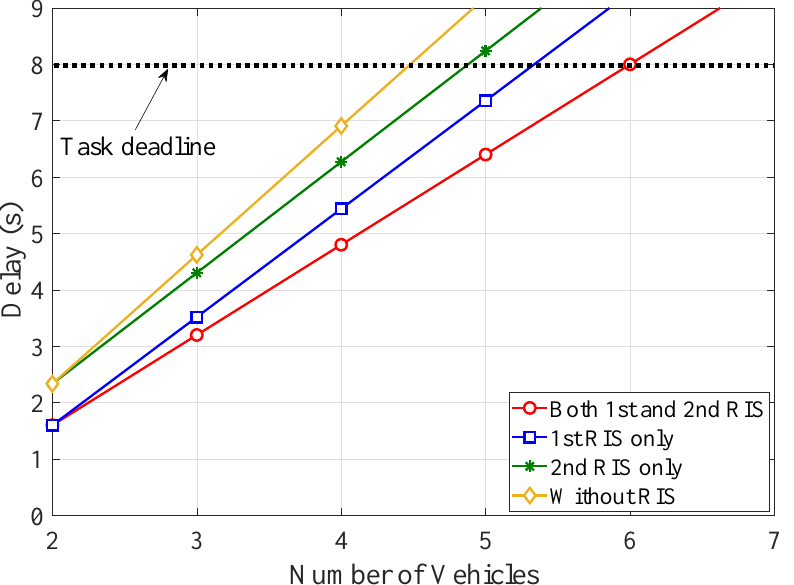
Figure 4. The TCCD as a function of the number of vehicles for different RIS deployment